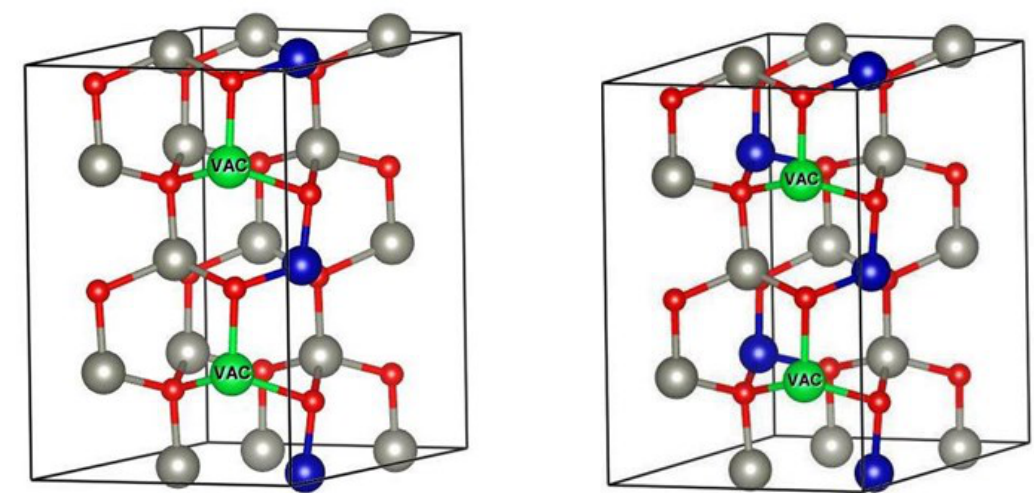
Fig. 1. 2x2x2 supercells of Zn 1-x Co x O for x=0.14 (left panel) and for x=0.28 (right panel). Grey balls are Zn, red – O, dark blue – Co atoms, green – Zn vacancies. Both structures are relaxed.